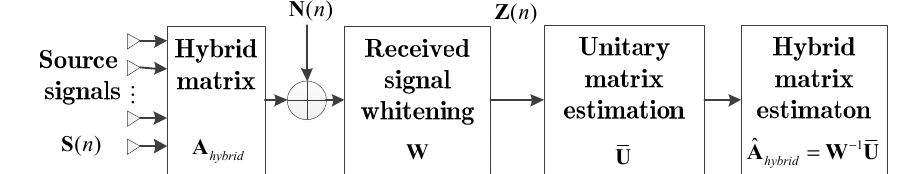
Figure 2. Flowing diagram of the joint approximation diagonalization of eigenmatrices (JADE) algorithm.